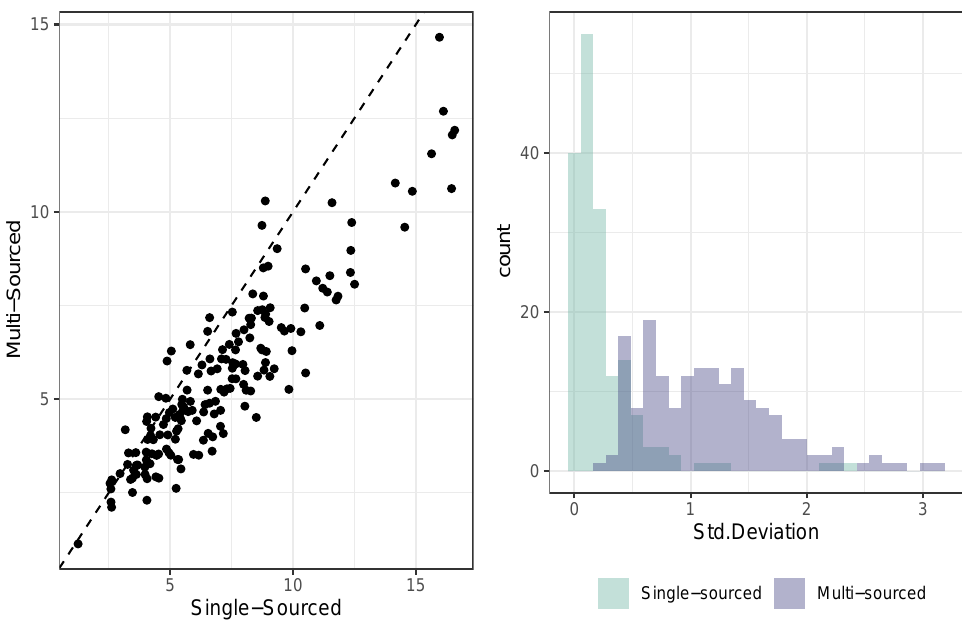
Figure 3. PM 2.5 concentration estimates obtained from both a multi-sourced and single-sourced exposure models and the comparison of model predictions using the daily spatial mean and standard